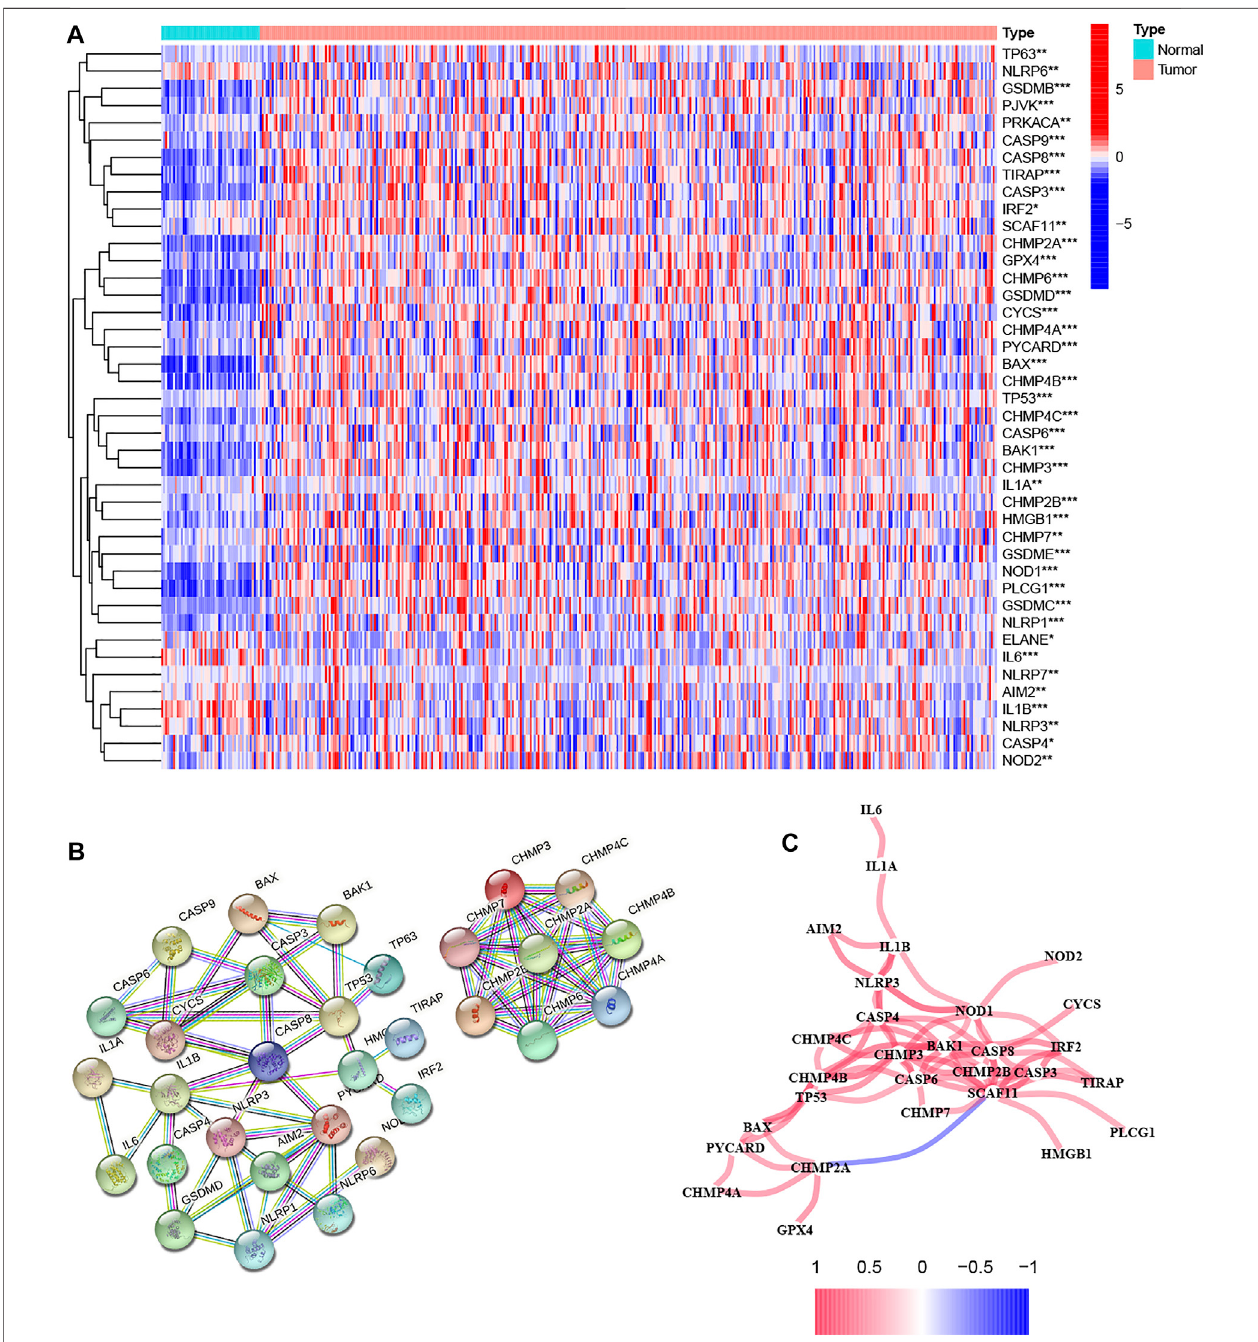
FIGURE 1 | Analysis of the differential expression of pyroptosis-related genes in tumor and normal tissues and their inter-regulatory effects. (A) The heatmap showed the expression levels of 42 pyroptosis-related genes in tumor and normal tissues, where red indicates high expression and blue indicates low expression. * p < 0.05, ** p < 0.01, and *** p < 0.001. (B) Protein – Protein Interaction interactions among hub pyroptosis-related DEGs. (C) The correlation network among pyroptosis- related DEGs, where red indicates positive regulation and blue indicates negative regulation. A darker color of the line between genes indicates a more signi fi cant